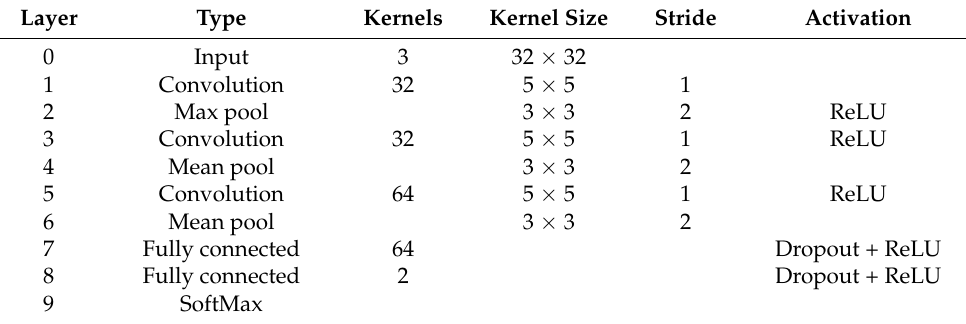
Table 2. Alexnet